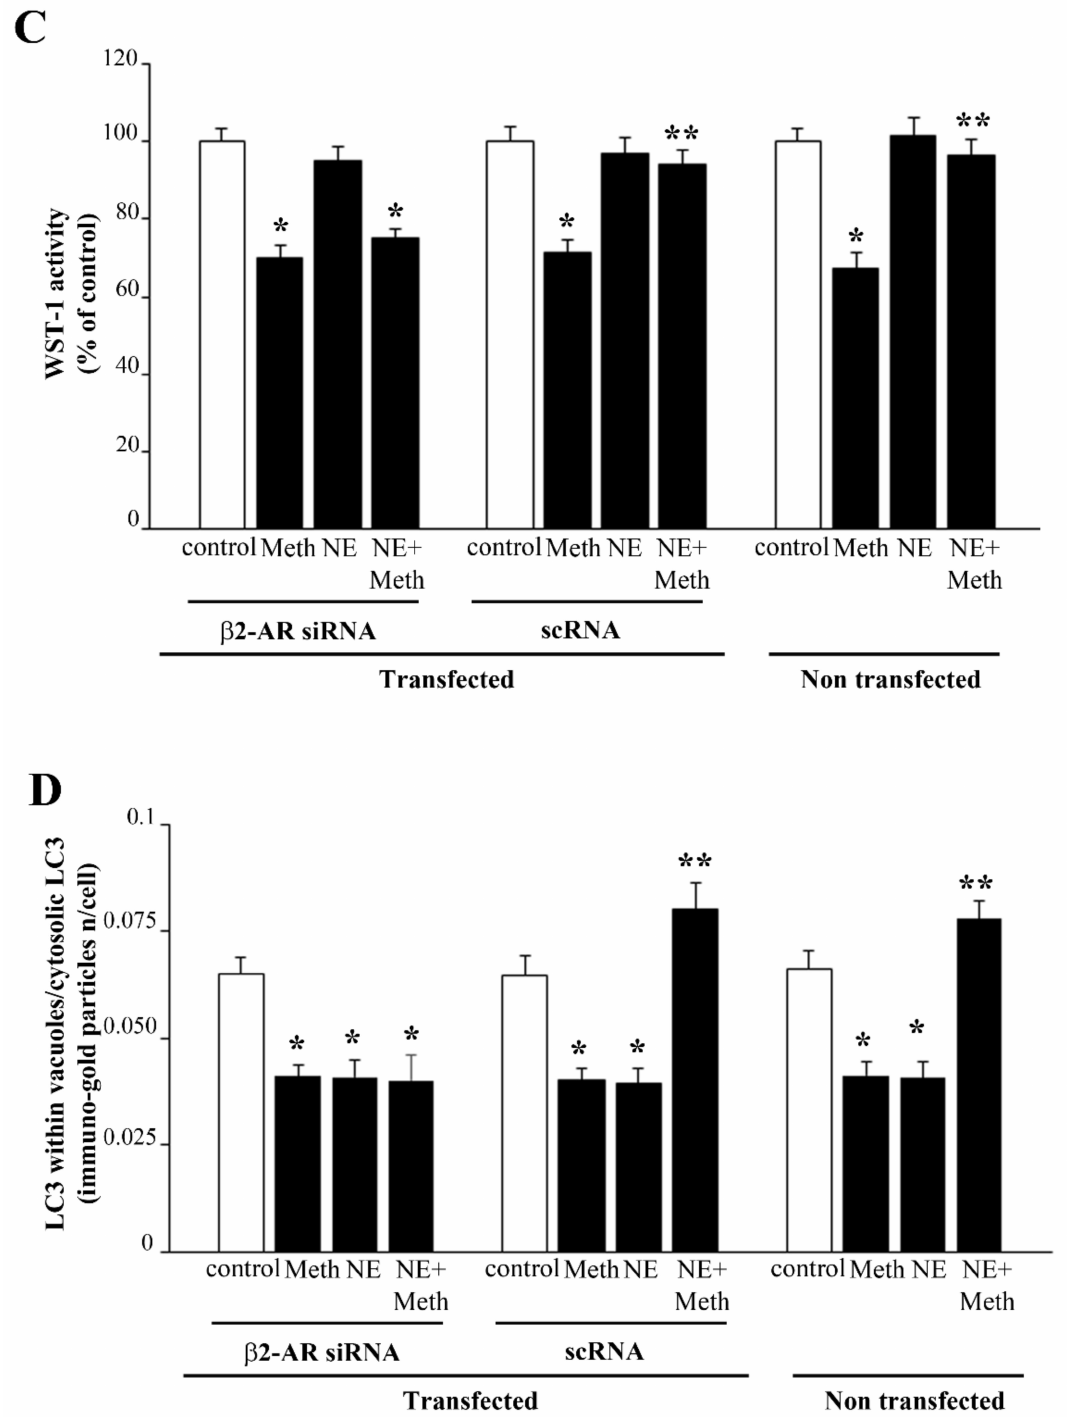
Figure 10. Transfection with β 2-AR siRNA suppresses the protective effects of NE against Meth. Cell viability in naive and β 2-AR siRNA- and scRNA-transfected cells, as evaluated by ( A ) TB, ( B ) H&E, and ( C ) WST-1 assay. ( D ) Dissipation of LC3 particles from vacuoles to the cytosol in β 2-AR silenced cells. (DF = 11) * p < 0.05 compared with control; ** p < 0.05 compared with